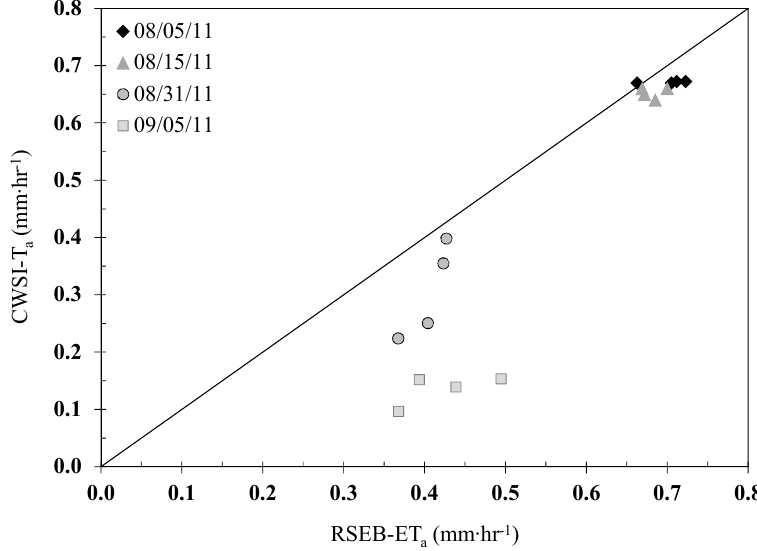
vs. remotely-sensed surface energy balance-actual evapotranspiration Figure 5. CWSI-T a (RSEB-ET ) estimates for four days in the summer of a